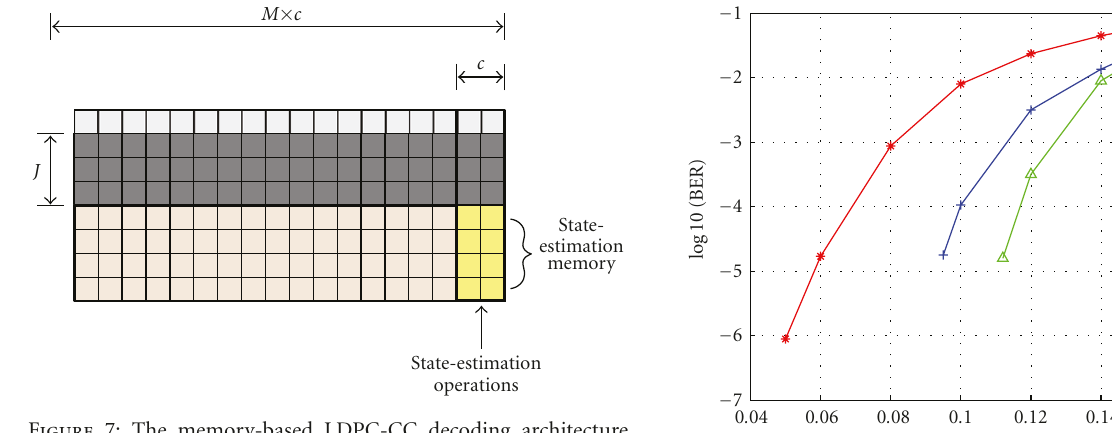
Figure 7: The memory-based LDPC-CC decoding architecture for a rate-1 / 2 code, highlighting the extramemory resources and additional operations needed to implement joint channel state estimation.